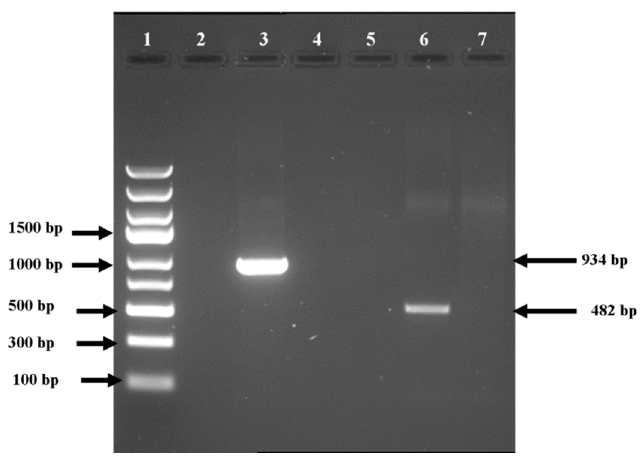
Figure 3. Gel image showing the PCR results of O . novo-ulmi genomic DNA amplification with primers CU1-Fwd and CU2-Rev for the cerato-ulmin gene (934 bp) and col1F and col1R for the colony 1 gene (482 bp). Lane 1 = O’ Gene Ruler DNA Ladder (ThermoFisher Scientific Inc. USA); Lane 3 = amplicon obtained with the CU1-Fwd and CU2-Rev primers; Lane 6 = amplicon obtained with the col1F and col1R primers pairs; Lane 7: Negative control (without DNA template).